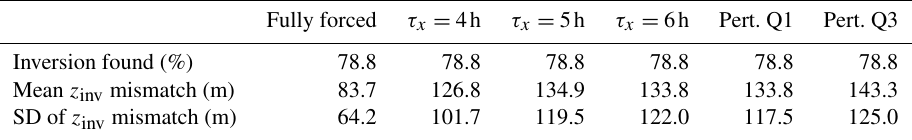
Table B1. Results from the modified EPIC SCM experiments: percentage of the time that the inversion is reconstructed, and the mean and standard deviation (SD) of the mismatch (absolute difference) between the reconstructed inversion height z inv and the measured cloud top (linearly interpolated to all model time steps). Results are presented for the fully forced simulation; nudged simulations with τ x of 4, 5, and 6h; and for the lower and upper quartiles of the 50 perturbed simulations of the τ x = 5h